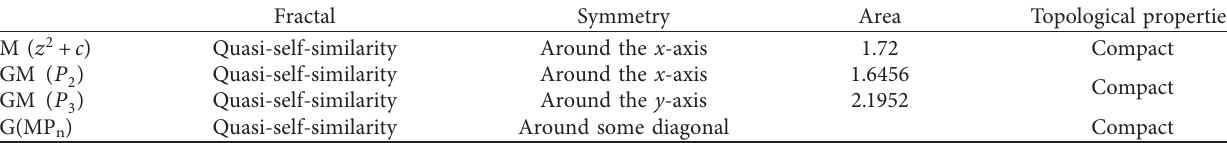
Table 1: Comparison between the Mandelbrot set generated with P ( z ) � z ^ 2 + c and the general Mandelbrot sets of GM(P_2) and